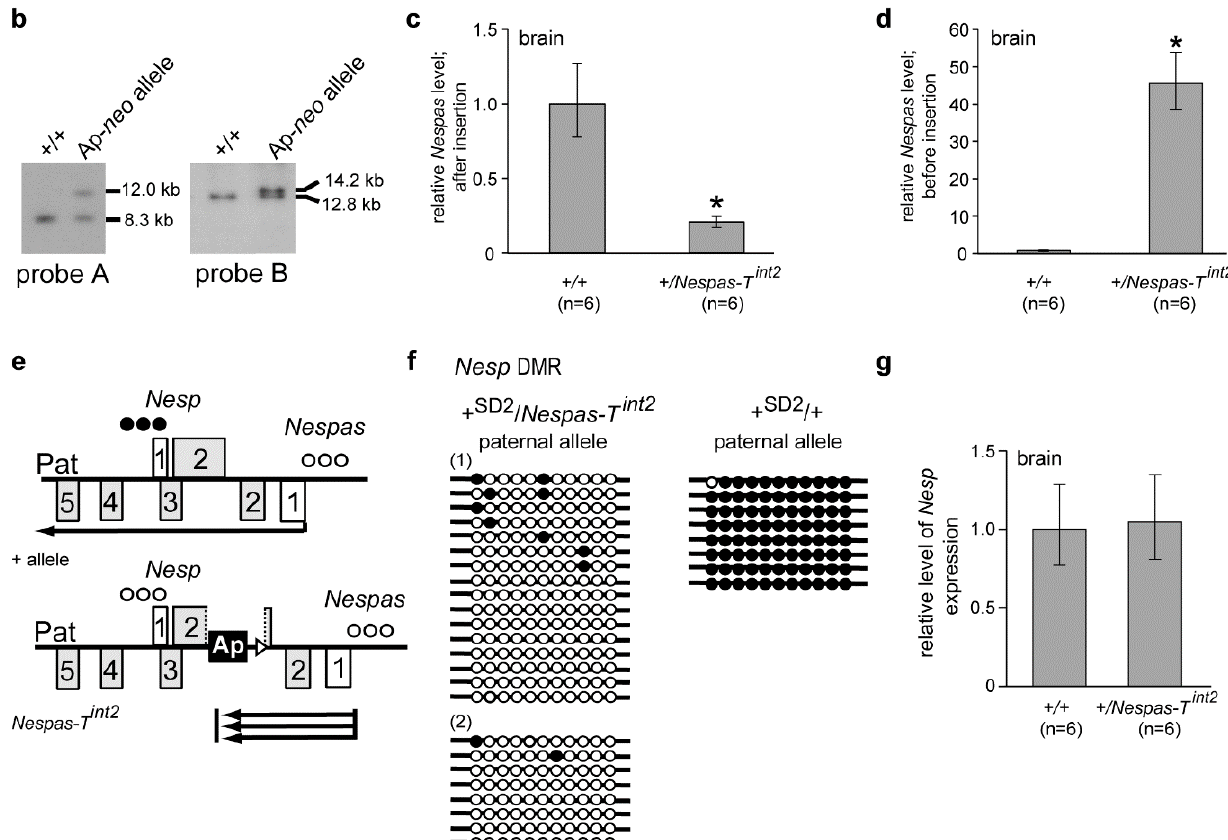
Figure 2. Truncation of Nespas before the Nesp promoter in Nespas intron 2/ Nesp exon 2. ( a ) Schematic of the mouse Gnas locus showing the site of insertion of the rabbit β-globin polyadenylation cassette [2]. The targeting vector shows the location of a 1.2 kb fragment (black box labelled Ap) from the rabbit β-globin gene to truncate Nespas and the position of the selection cassette (TKneopA URA3), flanked by loxP sites (open triangles). The targeted allele was designated Nespas-T int2 allele after Cre-mediated excision of the selectable marker cassette. Methylated DMRs are shown by filled circles. A, Afl II; X, Xho I; ICR, Imprinting Control Region. The arrow shows the approximate position of the polyadenylation cassette (pA) to truncate Nespas in exon 1 in Nespas-T ex1 [4]; ( b ) Southern analysis of ES cell DNA showing correct targeting in the Ap- neo allele. Ap- neo targeted clones were identified by the presence of a 12.0 kb Afl II fragment detected with the 5' external probe, probe A. Correct targeting at the 3' end was confirmed by the detection of a 14.2 kb Xho I fragment with Probe B; ( c ) Nespas is downregulated after the insertion; ( d ) Nespas is upregulated before the insertion; ( e ) Nespas is truncated and abundant in +/ Nespas-T int2 ; ( f ) Bisulphite analysis showing the Nesp DMR is unmethylated on the paternal allele in + SD2 / Nespas-T int2 . All clones from one individual are grouped into a block and two + SD2 / Nespas-T int2 individuals, (1) and (2), and one + SD2 /+ individual were analysed. Each row of circles represents a clone derived from the paternal allele and each circle corresponds to a separate CpG (filled circle, methylated CpG; unfilled circle, unmethylated CpG) for nucleotides 140,450–140,800; ( g ) The Nesp level is unaffected in +/ Nespas-T int2